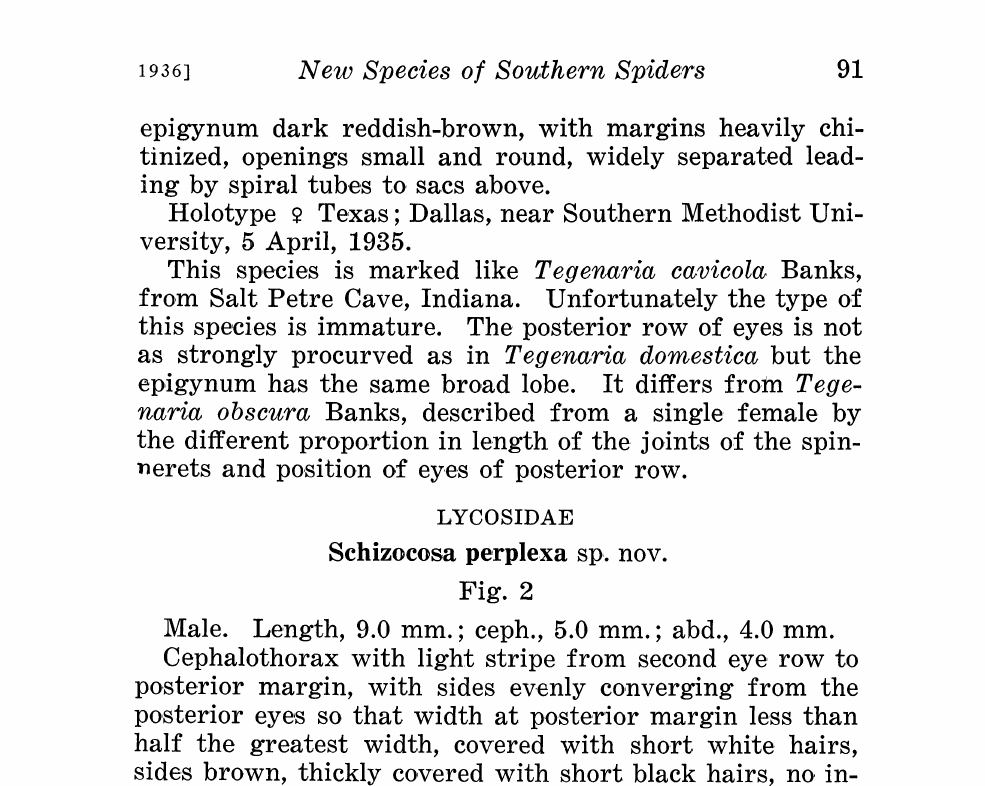
Male. Length, 9.0 mm. ceph., 5.0 mm. abd., 4.0 mm. Cephalothorax with light stripe from second eye. row to posterior margin, with sides ev.enly co.nverging from the posterior eyes so that width at posterior margin less than half the. greatest width, covered with short white hairs, sides brown, thickly co.vered with short black hairs, no. in- dications of submarginal light stripe, very dark about eyes; eyes anterior row shorter than second row, a.m.e, separated by little over a radius, larger than a.l.e, and separated from them by less than a radius, eyes of second row separated by about a diameter; mandibles dark brown, covered with long black hairs, vertical, superior margin of fang groove with three teeth, middle, largest, inferior margin with three sub- equal teeth; labium higher than wide, lateral excavations at ba.se about one third the length; maxillm twice as high as labium; sternum and coxm light; abdomen with light brown basal stripe which disappears about middle:; in this the usual spear-mark can be traced outlined by black dots, sides black, entire abdomen thickly covered with long dark hairs and a few longer white hairs at base. on light stripe; venter dark with a few scattered lighter spots and a nar- row, median light stripe, from fold to. spinnerets; legs,